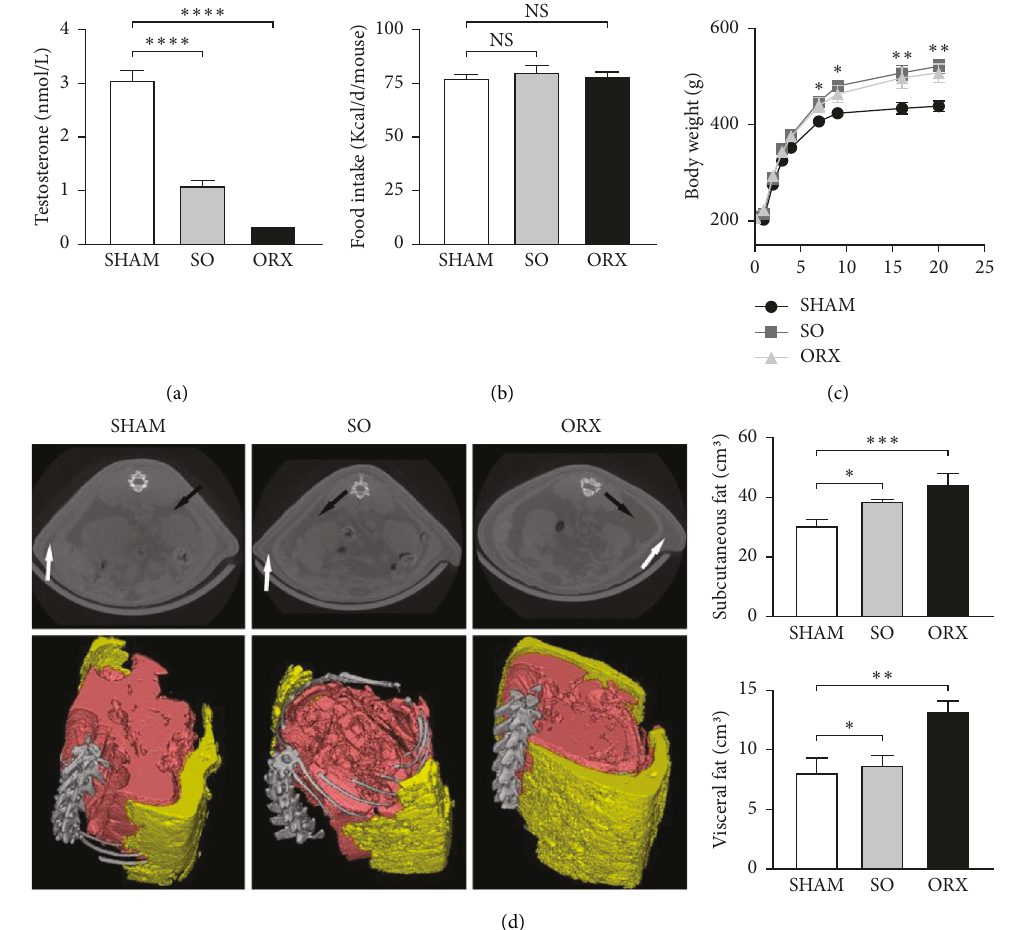
Figure 1: Metabolic characteristics of sham-operated (SHAM), subtotal orchiectomized (SO) and orchiectomized (ORX) rats. (a) Serum testosterone level six weeks after operations. Rats in SO and ORX groups displayed markedly reduced testosterone levels as expected. Testosterone level of rats in ORX group were all under the lower limit of the measurement (b) Food intake of the rats during the ex- perimentation. (c) The body weight alteration of rats within 20 weeks. (d) Representative graphs of computed tomography (CT) scanning and three-dimensional reconstructed models (yellow: subcutaneous fat; red: visceral fat) of SHAM, SO and ORX group. Volume of subcutaneous and visceral fat are analyzed from the images. Black and white arrows indicates visceral and subcutaneous fat of SHAM, SO and ORX rats respectively. Data are presented as mean SEM. Statistical analyses are unpaired t -test or one-way ANOVA. P 0 . ± <